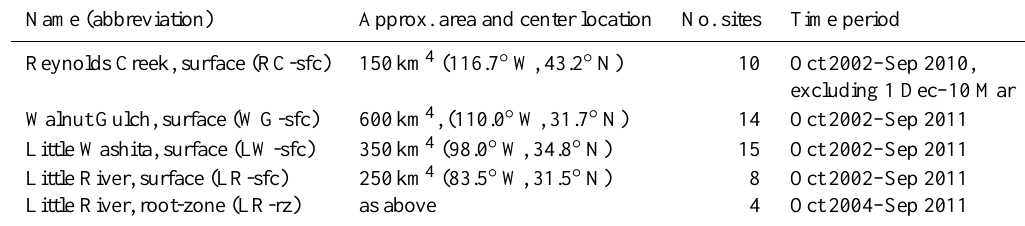
Table 1. Location, time period, and number of in situ network sites at each